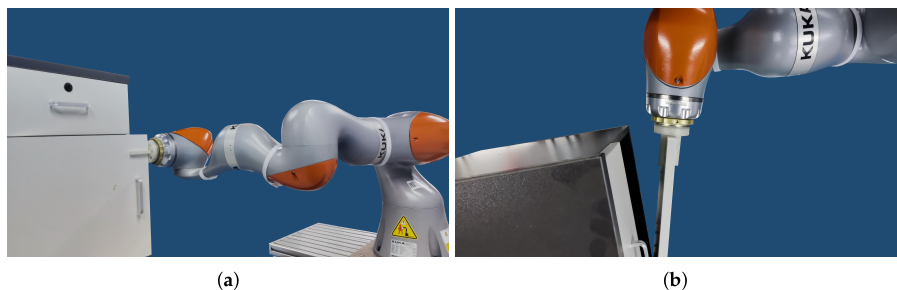
Figure 16. The desired trajectory, the trajectory of the end of the undeformed door, the trajectory of the end effector of the two-link robot and the corresponding stiffness ellipse of some trajectory points in the door-opening task.